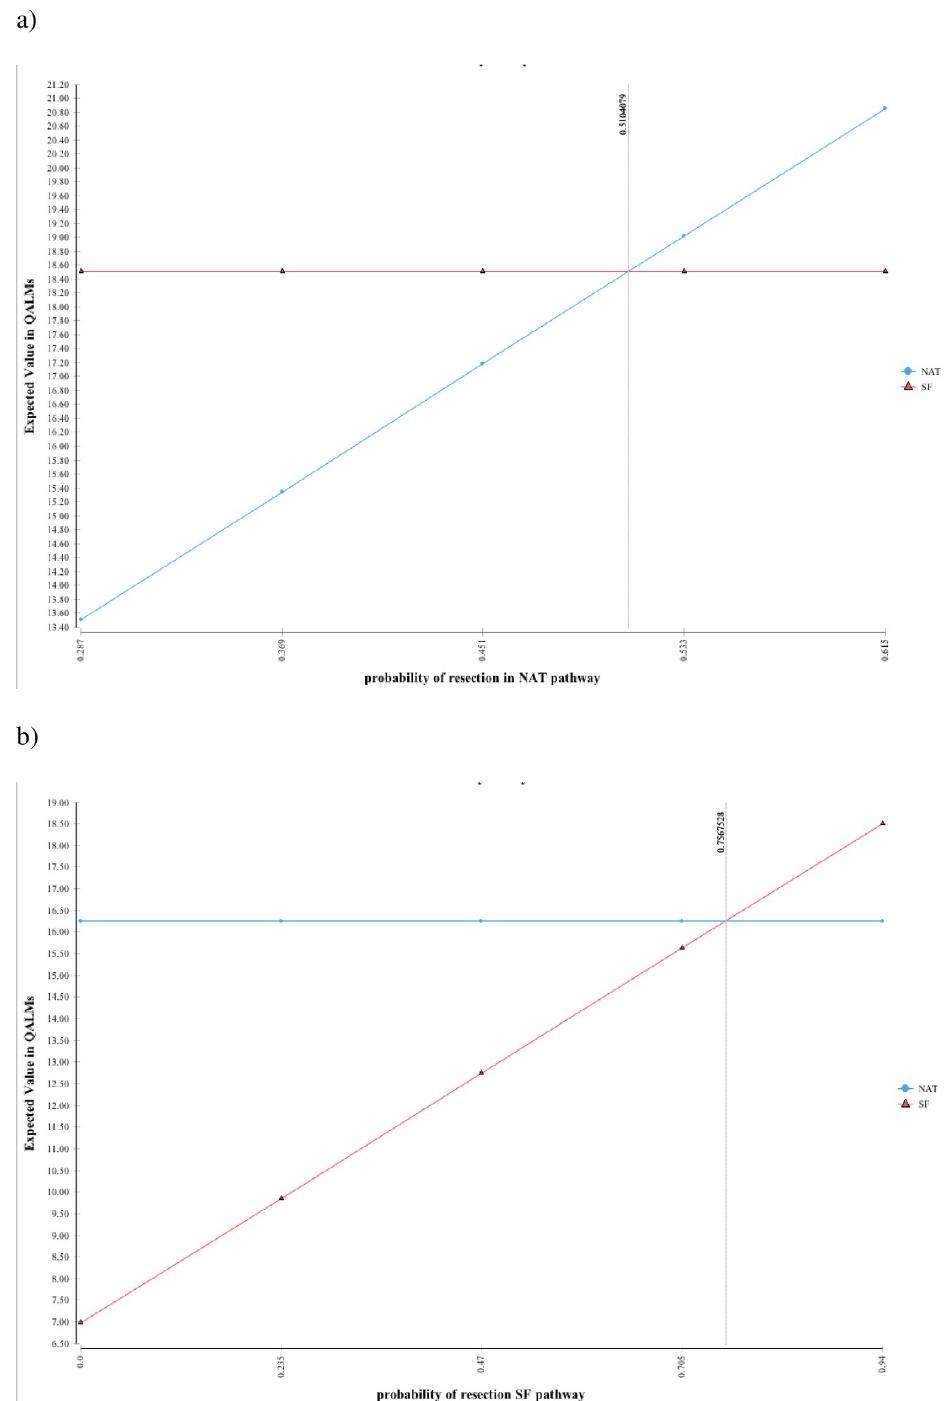
Fig 2. One-way deterministic sensitivity analysis. This figure shows the effect of altering the baseline probability of resection first in the NAT pathway then in the SF pathway on overall model outcome.